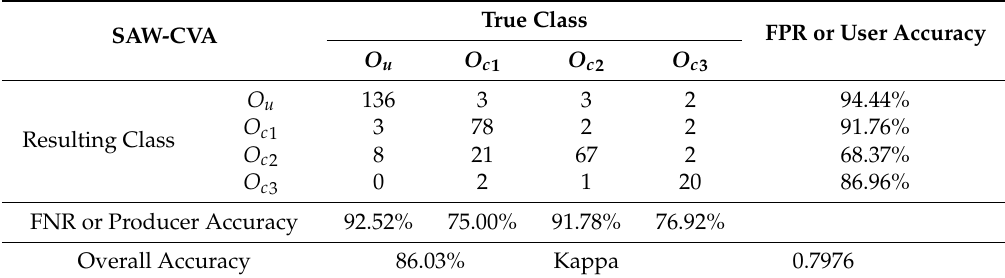
Table 1. The accuracy assessment for the OBCD result obtained by the proposed SAW-CVA approach.